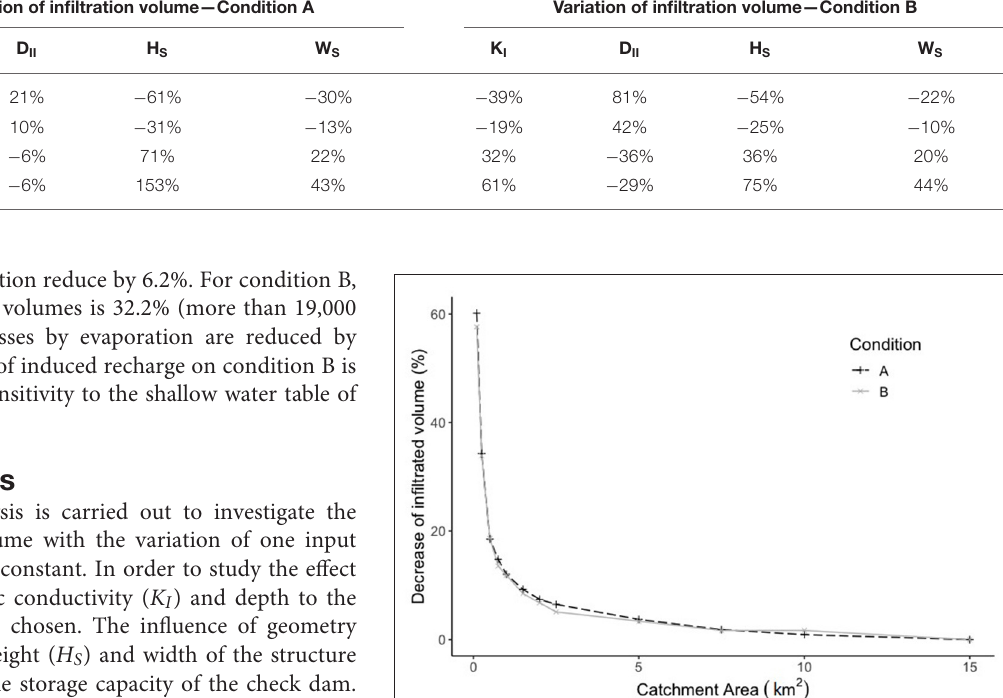
TABLE 4 | One-at-a-time sensitivity analysis of average infiltration volume for hydraulic conductivity of the upper layer (KI), depth to the underlying layer (DII), height of the structure (Hs), and width of the structure (Ws), ranging from − 50 to + 100%. Variation of infiltration volume—Condition A Variation of infiltration volume—Condition B